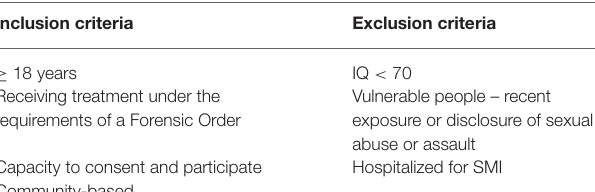
TABLE 1 | Inclusion and exclusion